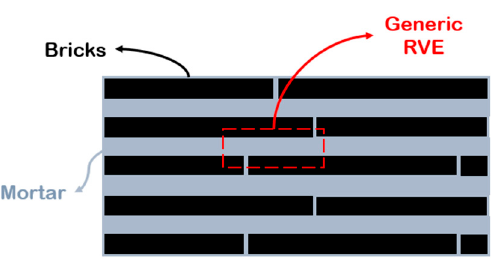
Figure 11. Schematic illustration of brick-and-mortar composites.